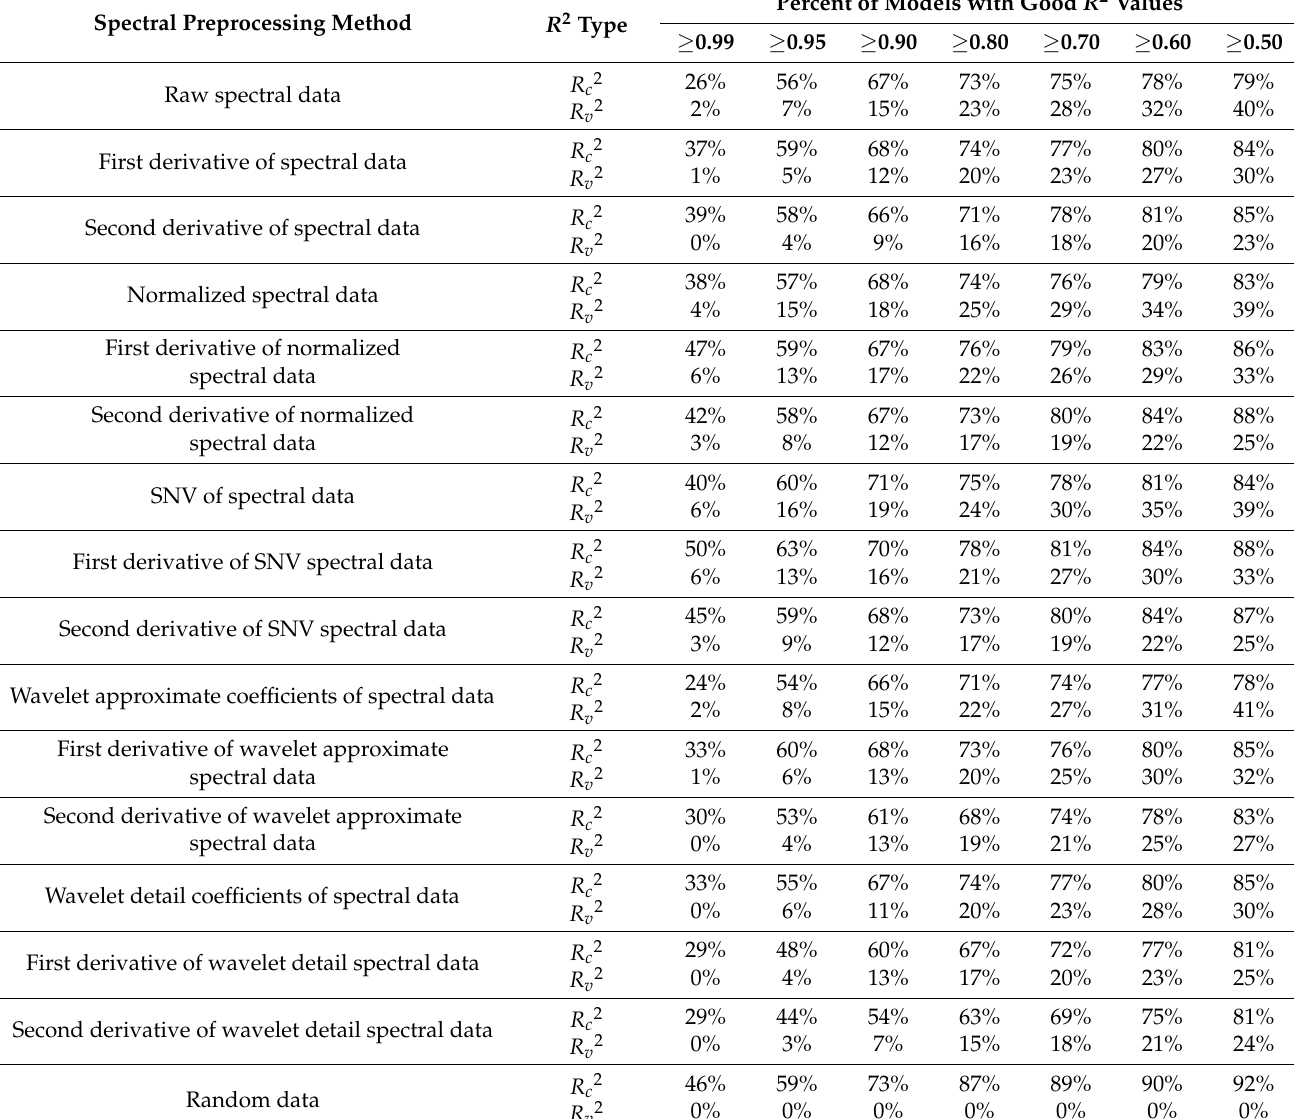
Table 1. Comparison of the R c 2 and R v 2 values obtained for models based on spectral and random